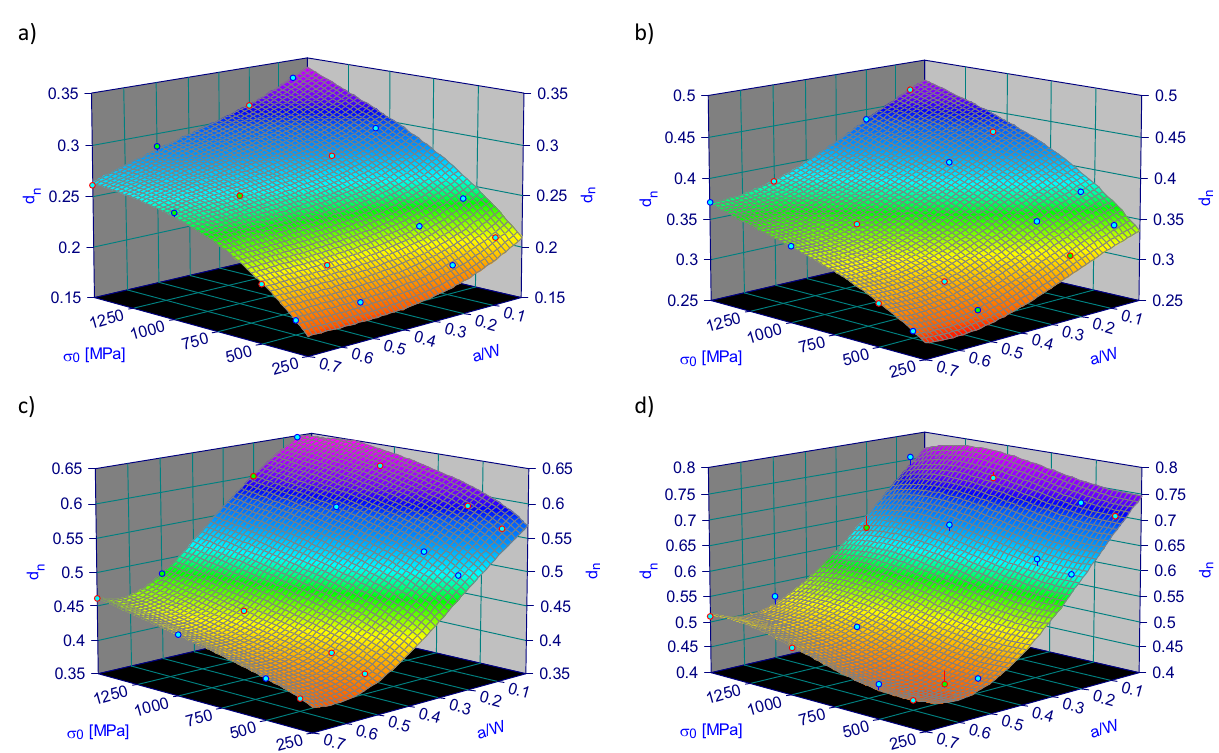
Figure 12: Change in the value of the d n coe ffi cient as a function of the yield stress σ 0 and the relative crack length a / W , numerically determined for materials with di ff erent degrees of hardening, expressed by the strain hardening exponent: ( a ) n = 3.36, ( b ) n = 5, ( c ) n = 10, and ( d ) n = 20.